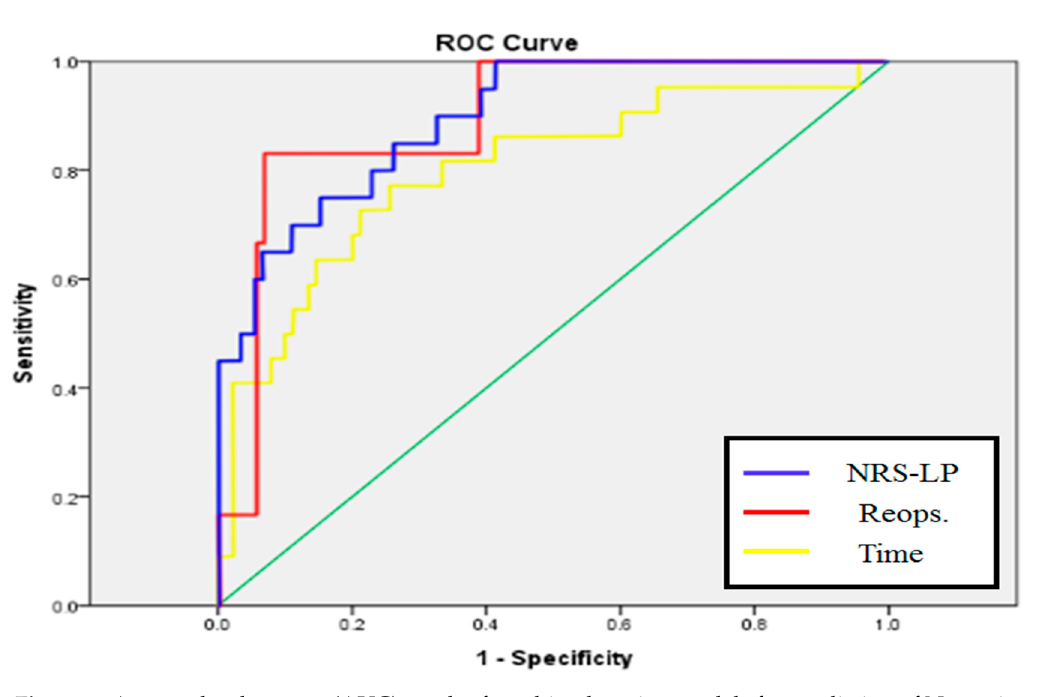
Figure 1. Area under the curve (AUC) result of machine-learning models for prediction of Numeric Rating Scale (NRS)-LP, reoperation, and time.